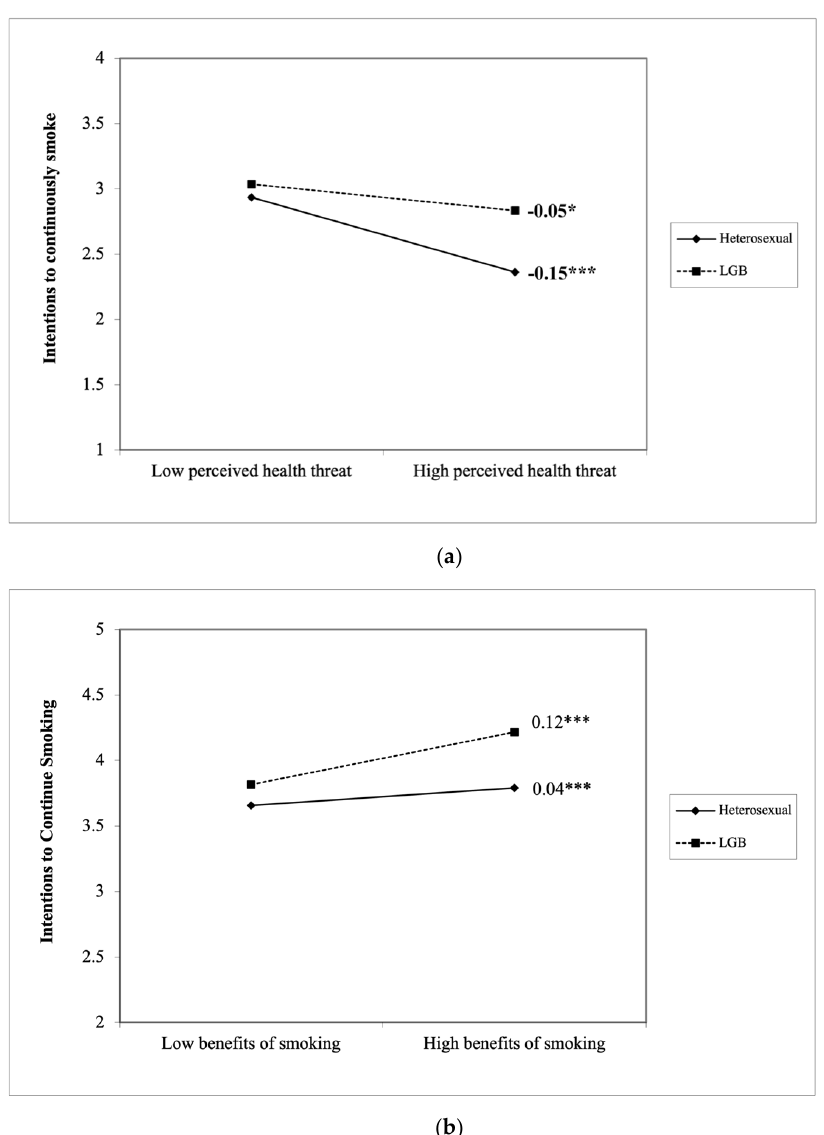
Figure 1. ( a ) LGB moderates how the perceived health threat of smoking predicts intentions to continue smoking. ( b ) LGB moderates how perceived benefits of smoking predicts intentions to continue smoking. *** p < 0.001, * p < 0.05.